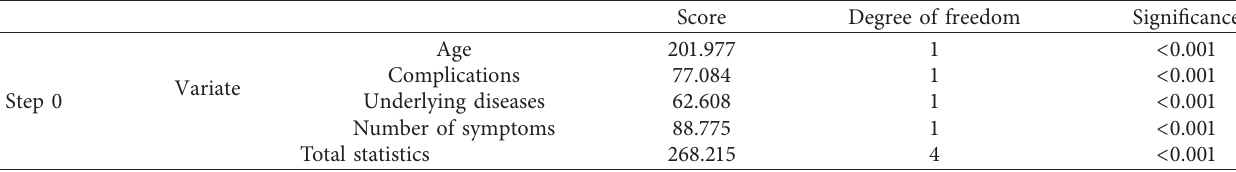
Table 3: Analysis of clinical symptoms in common and severe types of COVID-19 in classification analysis.